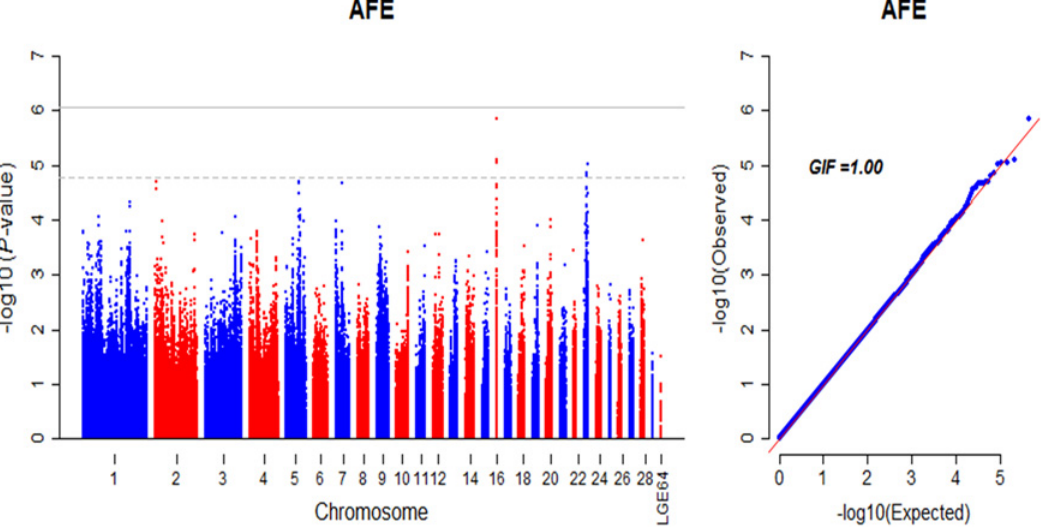
Fig 7. Manhattan and Q-Q plot of genome wide association study for age at first egg. Each dot represents a SNP in the dataset. Manhattan plot (left). AFE, age at first egg. The horizontal gray line and gray dashed line indicate the genome-wise significance threshold (P-value = 8.43e-7) and genome-wise suggestive significance threshold (P-value = 1.69e-5), respectively. GIF represents genomic inflation